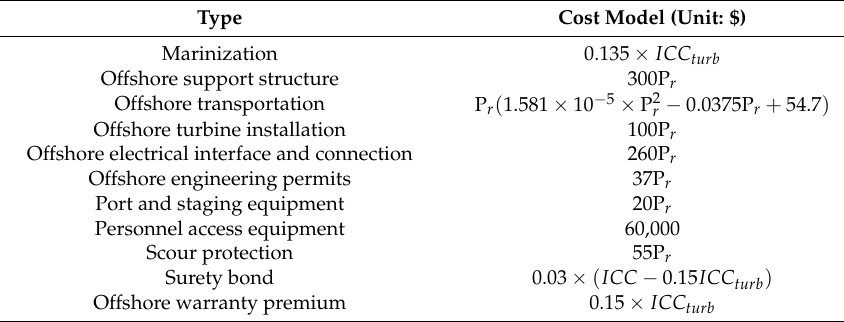
Table 2. The balance of the platform station